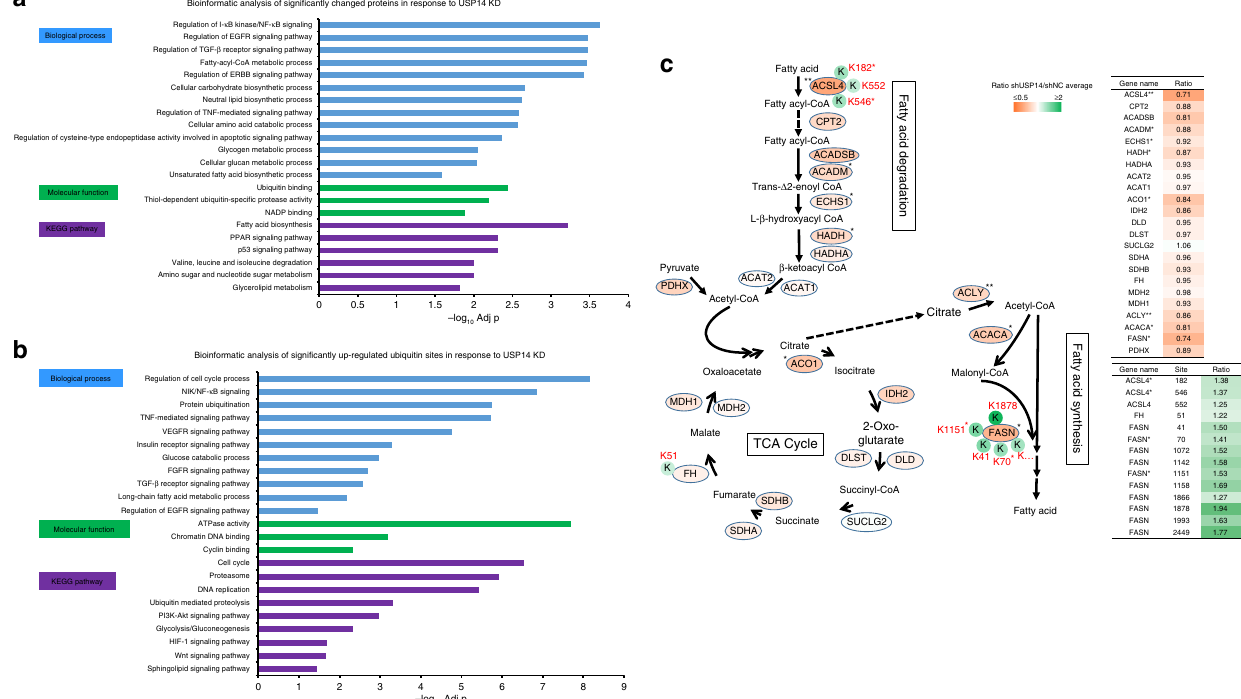
Fig. 3 Functional annotation of altered proteome and ubiquitinome in response to USP14 KD. a GO analysis of the signi fi cantly changed proteins identi fi ed in SILAC process for biological process, molecular function, and KEGG pathway. b GO analysis of the signi fi cantly upregulated ubiquitin sites for biological process, molecular function, and KEGG pathway. c Fatty acid and TCA cycle pathway change in response to USP14 KD. Most key enzymes were signi fi cantly downregulated in metabolic processes, such as fatty acid degradation, fatty acid synthesis, and TCA cycle. De fi ciency of USP14 leads to the decrease of fatty acid and lessens fatty acid degradation. * p < 0.05; ** p < 0.01(Student ’ s t